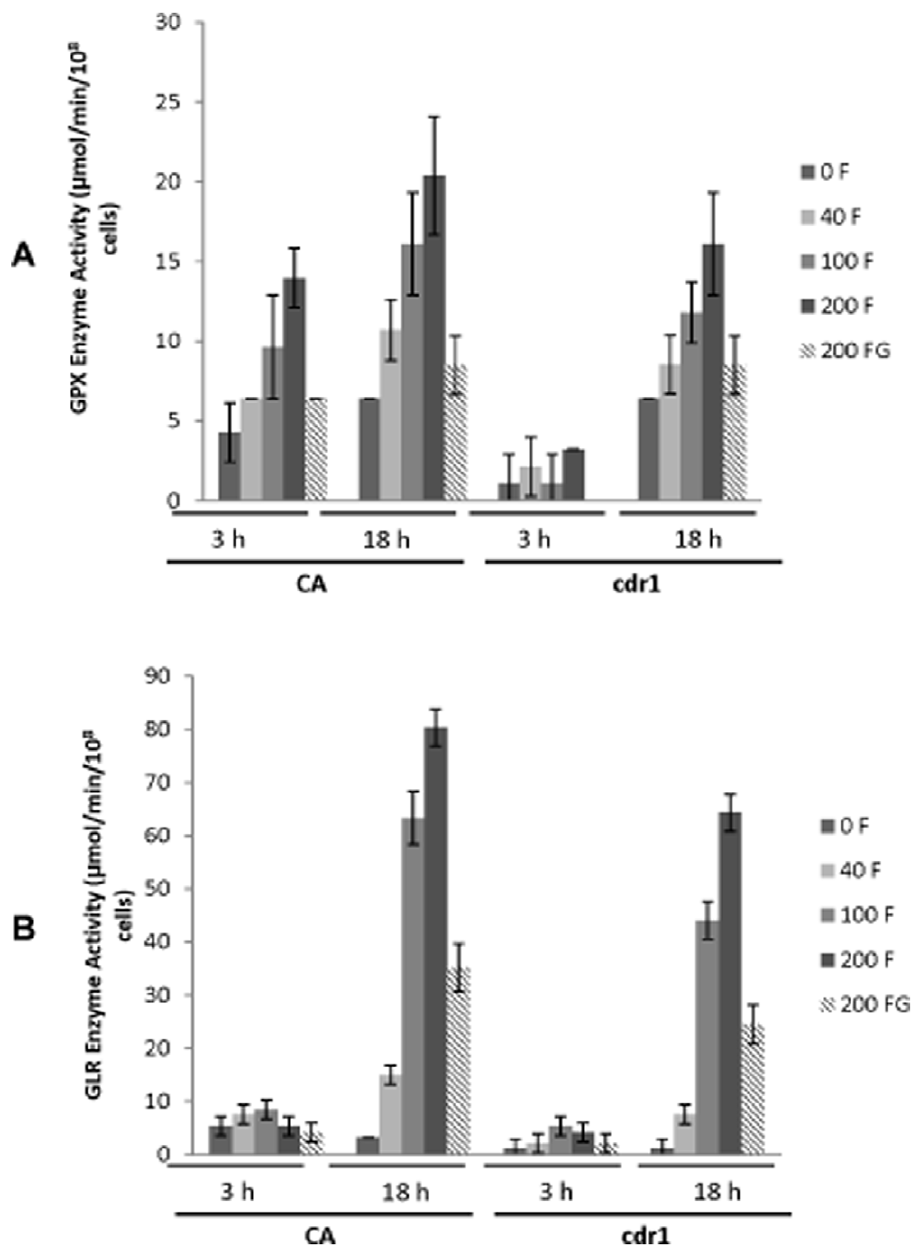
Figure 7. Effect of farnesol on glutathione peroxidase (GPX) and glutathione reductase (GLR) intracellular enzyme activity in CA and cdr1 following 3 h and 18 h exposure to increasing concentrations of farnesol. ( A ) Farnesol dose-dependent increase in GPX activity in CA following 3 h and 18 h exposure to farnesol. Similar increase in cdr1 at 18 h with no change at 3 h ( B ) Increase in GLR activity in CA and cdr1 at 18 h with cdr1 exhibiting less activity than CA. In contrast, no effect on GLR activity was noted in both strains following 3 h exposure to farnesol. However, activity of both enzymes was restored to near baseline levels in the presence of exogenous glutathione. In all experiments, GSH supplementation maintained enzyme activity at normal baseline levels. Error bars indicate the standard errors of the means. p ,